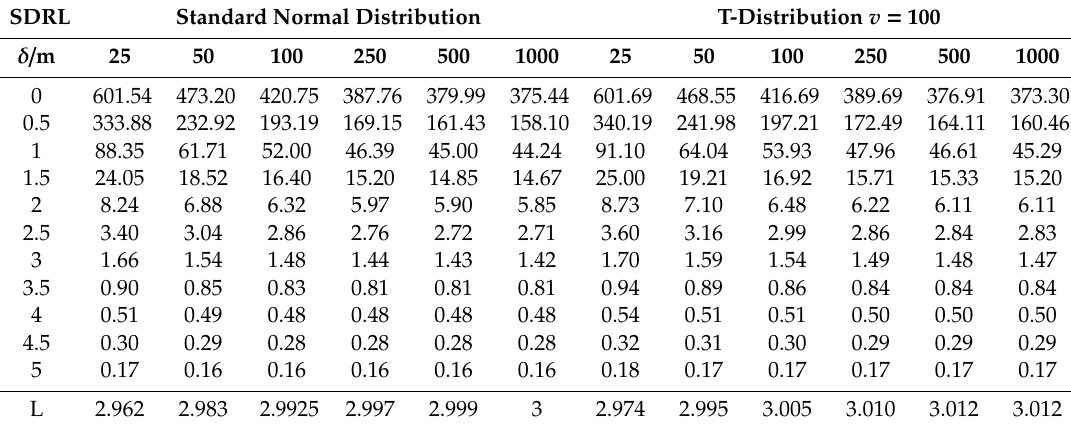
Table 2. Standard deviation of the run length (SDRL) of the Shewhart chart with estimated parameters for standard normal and t ( v = 100) distributions. SDRL Standard Normal